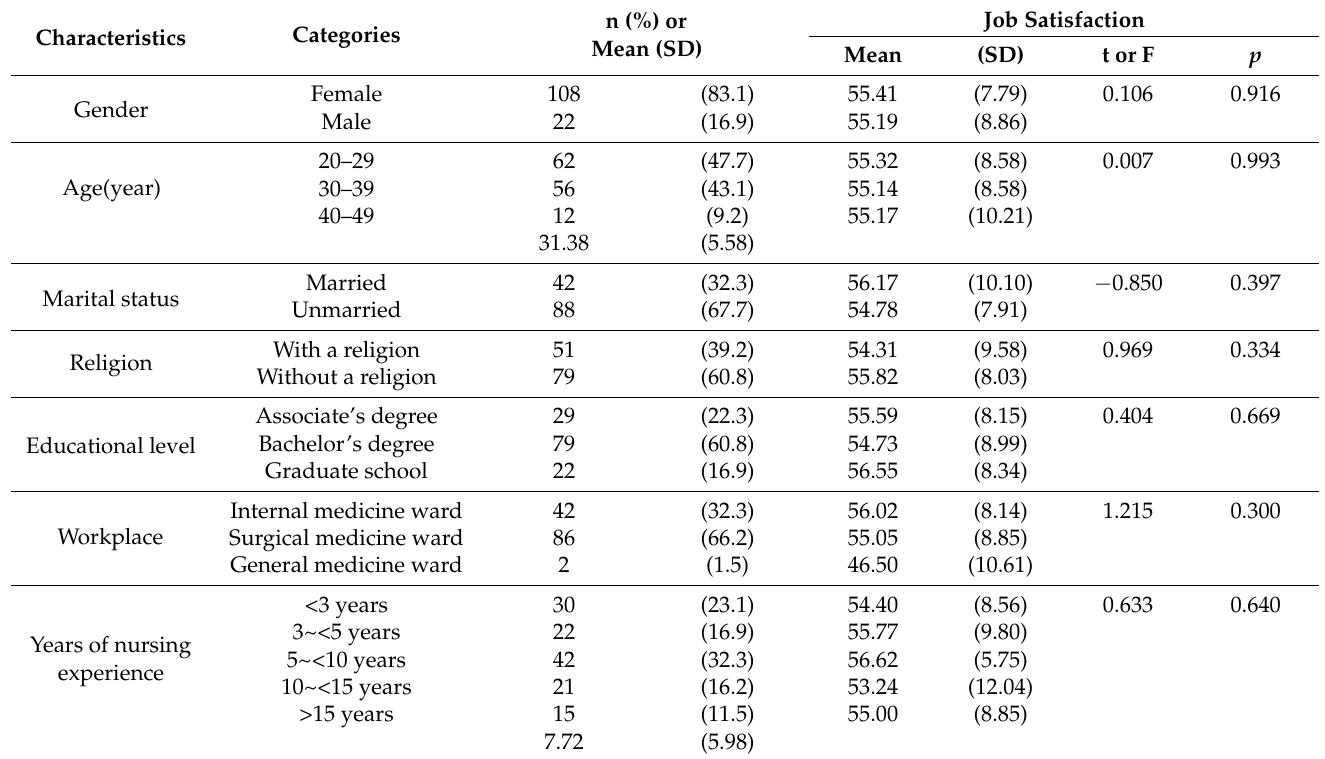
Table 1. General characteristics and differences in job satisfaction according to general characteristics (n =